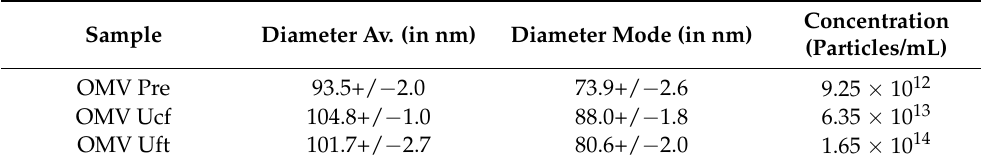
Table 1. Nanoparticle tracking analysis—diameter and concentration.